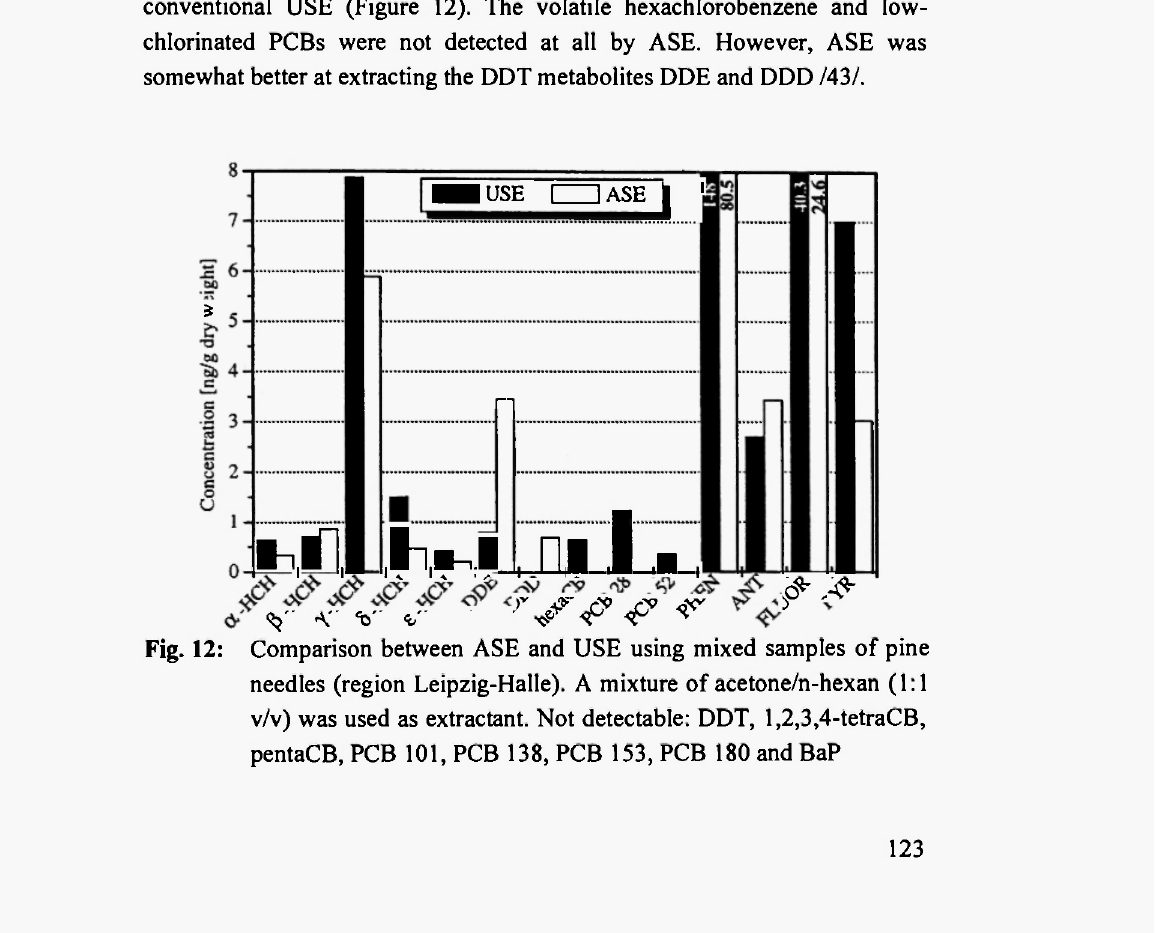
e <r Comparison between ASE and USE using mixed samples of pine needles (region Leipzig-Halle). A mixture of acetone/n-hexan (1:1 v/v) was used as extractant. Not detectable: DDT, 1,2,3,4-tetraCB, pentaCB, PCB 101, PCB 138, PCB 153, PCB 180 and